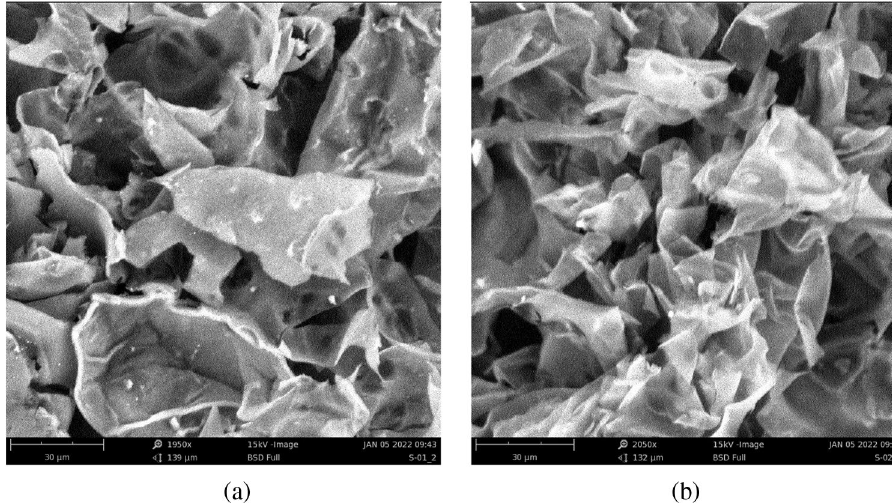
ylene blue dye, coconut coir dust before adsorption and coconut coir dust after adsorption